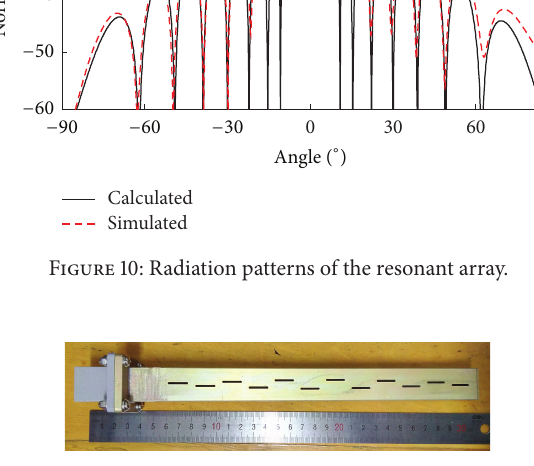
Figure 11: Photograph of the resonant waveguide slotted array.